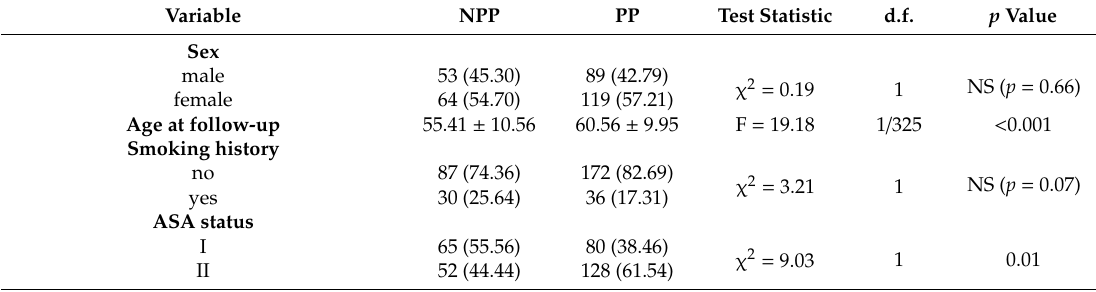
Table 1. Overall loaded implants: PP / NPP-groups distribution according to study variables. PP = patients with history of periodontal disease; NPP = patients without history of periodontal disease; ASA = American Society of Anesthesiologists physical status classification. Age at follow-up and oral professional hygiene / year are presented as mean ± standard deviation; for all other variables, values are presented as n (%); NS = not statistically significant; d.f. = degrees of